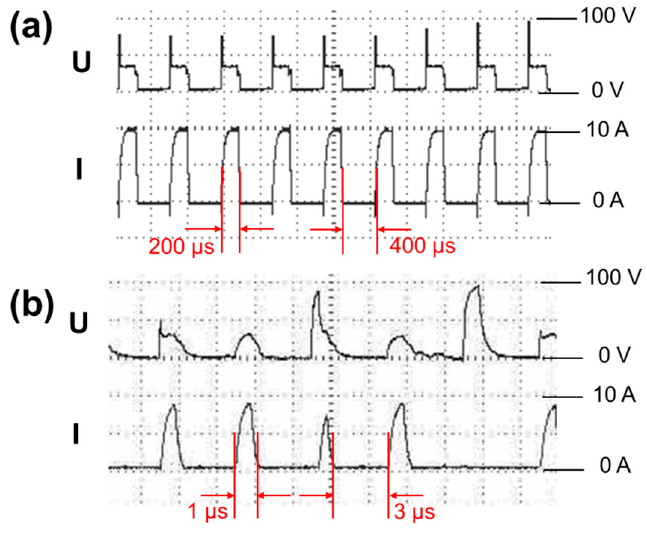
Figure 6. Discharge waveforms of ( a ) Si L and ( b ) Si S during spark erosion.